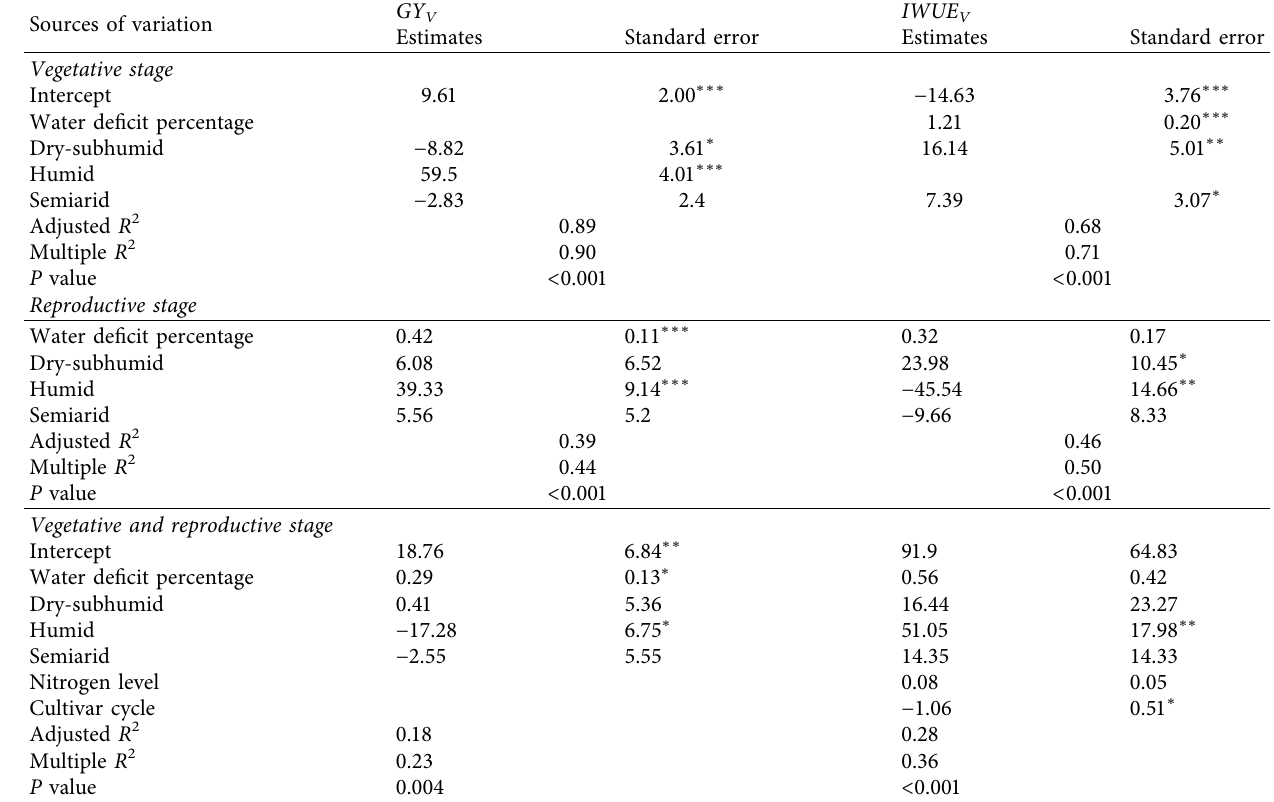
Table 3: Results of the best regression model of GY